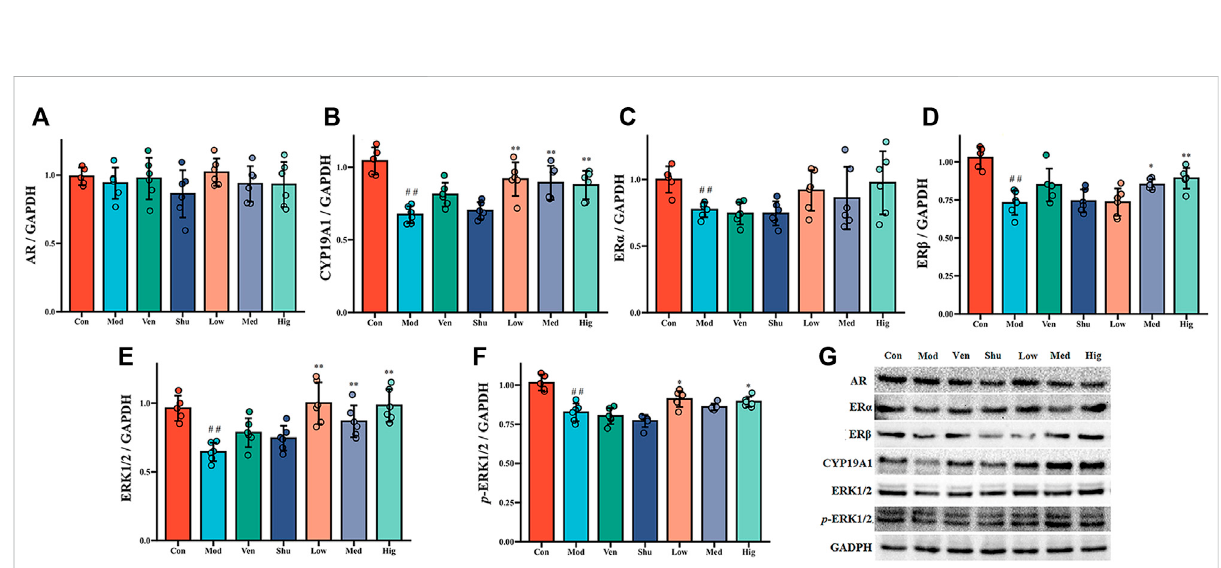
FIGURE 5 The effect of Chaigui granule on protein expression of CYP19A1-E2-ERK1/ERK2 pathway in the hippocampus. (A) The protein expression of AR in the hippocampus. (B) The protein expression of CYP19A1 in the hippocampus. (C) The protein expression of ER α in the hippocampus. (D) The protein expression of ER β in the hippocampus. (E) The ratio of ERK1 and ERK2 protein expression in the hippocampus. (F) The ratio of p-ERK1 and p-ERK2 (G) protein expression in the hippocampus. All data were expressed as mean ± SD. # p < 0.05, ## p < 0.01 compared with Control group. ✻ p < 0.05, ✻✻ p < 0.01 compared with Model